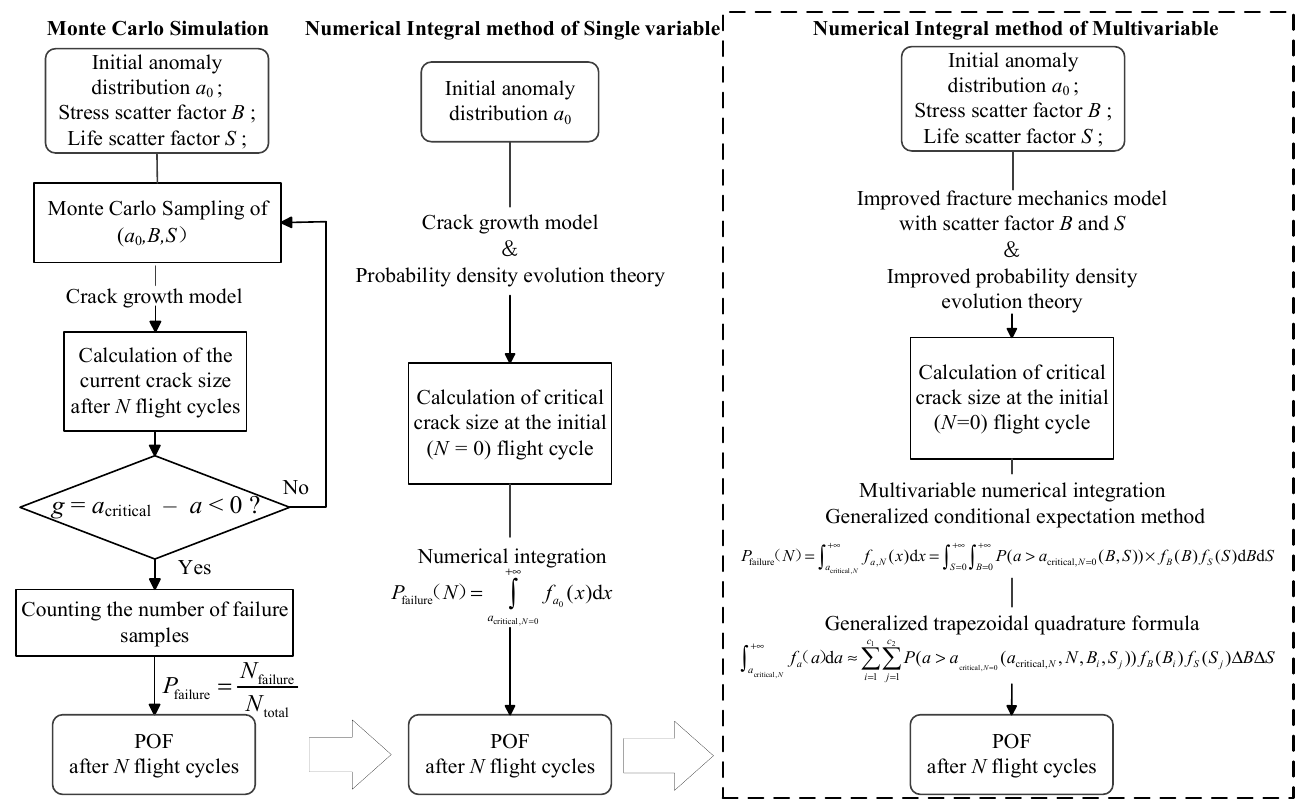
Figure 2. Comparison of the processes between the MCS and NI methods under both single-variable and multivariable conditions.